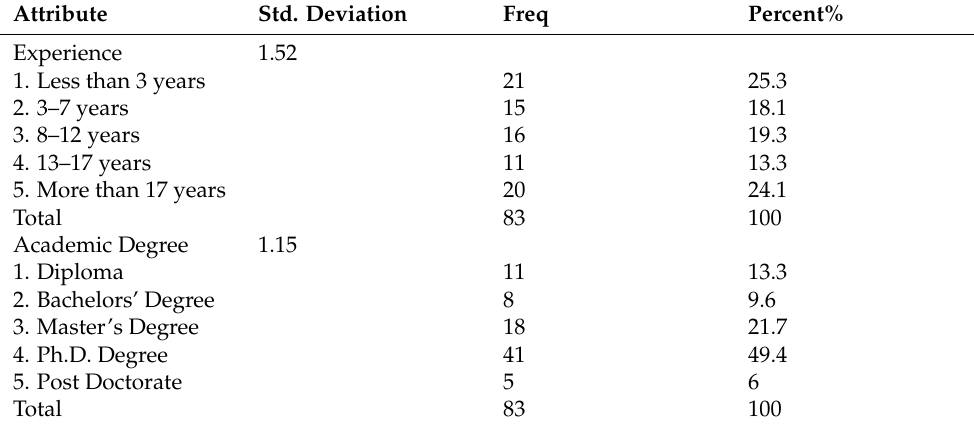
Table 1. Respondents’ demographics of experience and academic degree.